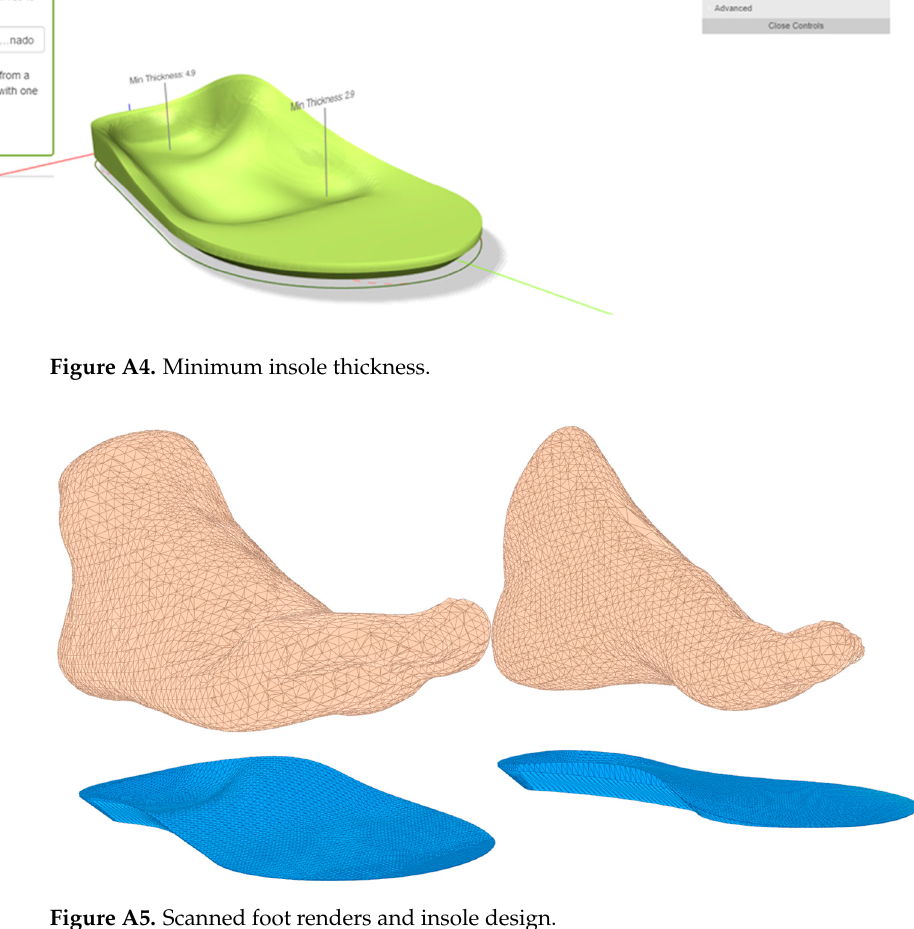
Figure A5. Scanned foot renders and insole design.